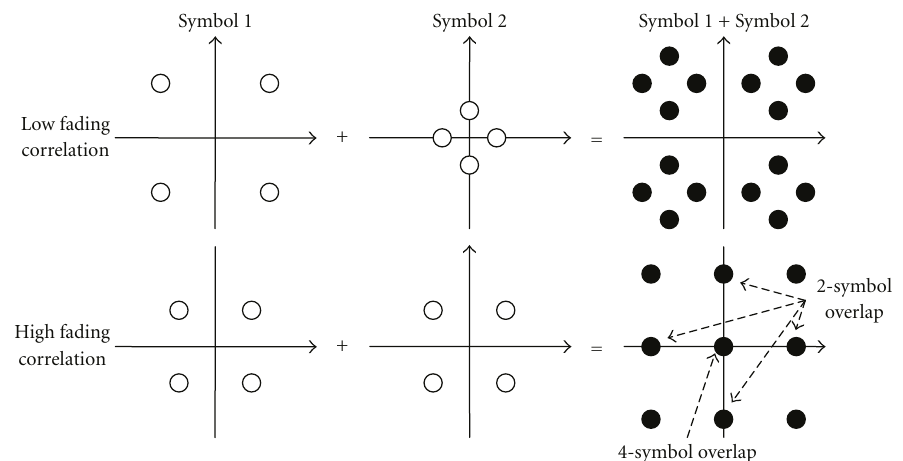
Figure 3: Impact of fading correlation on surviving symbol selection in M -algorithm (QPSK modulation is